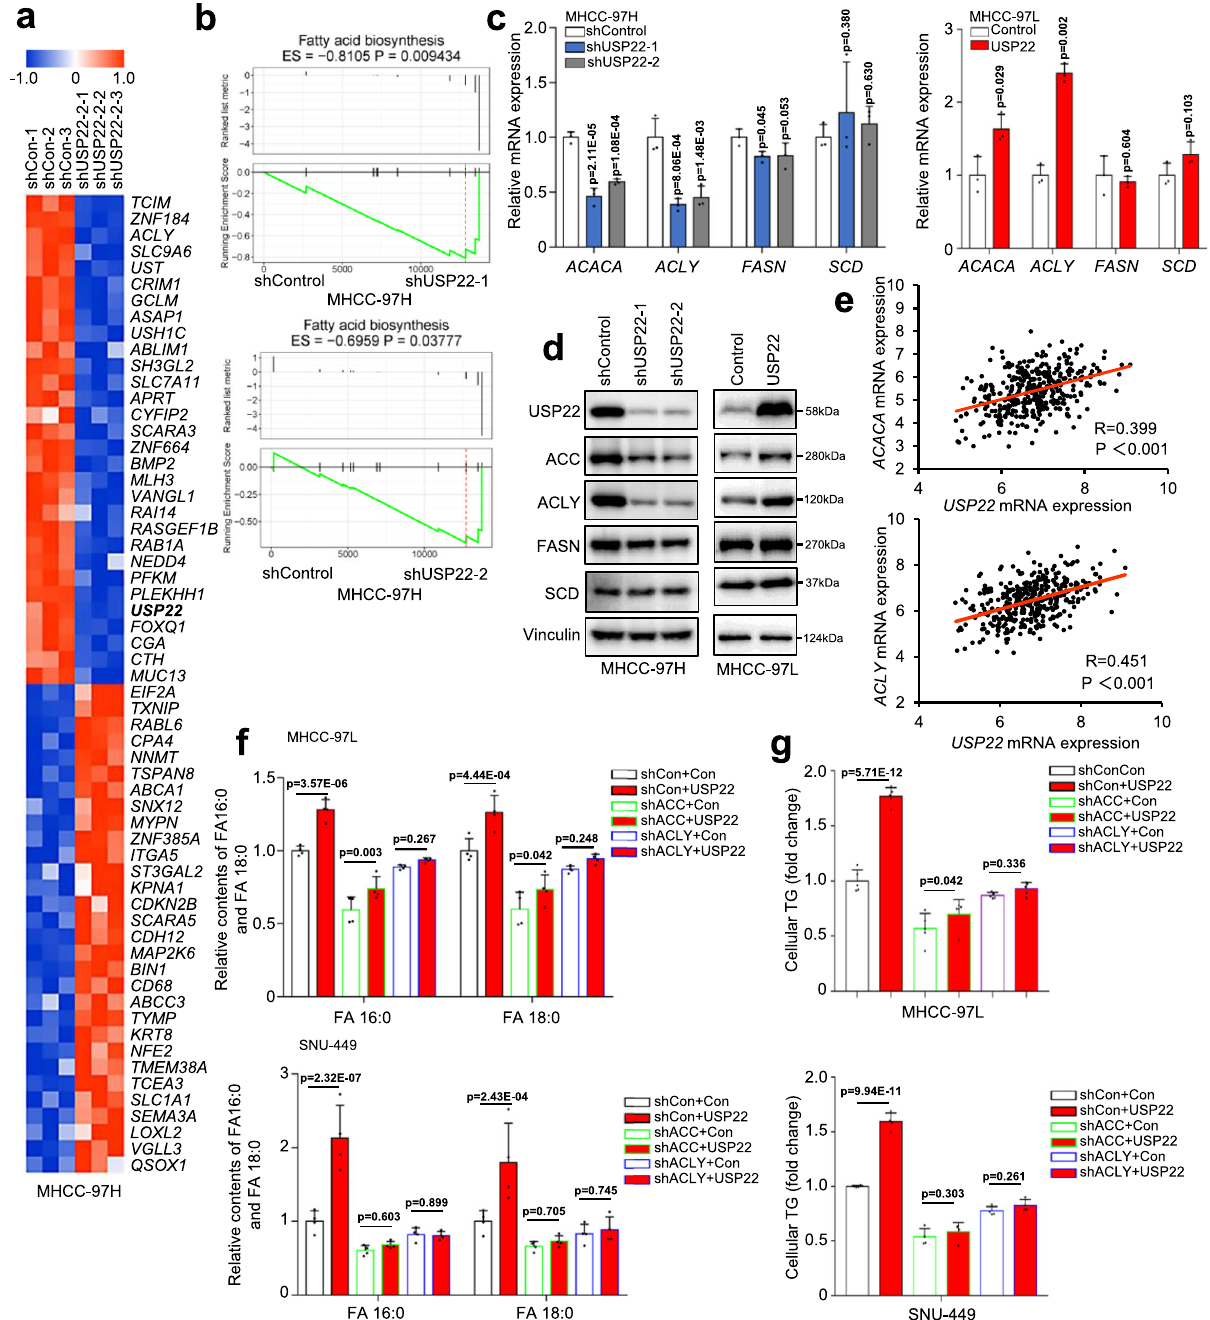
Fig. 3 USP22 upregulates ACC and ACLY expression. a Heatmap depicting the top 30 downregulated and upregulated genes in MHCC-97H cells transduced with USP22 shRNA ( Q < 0.05). Red and blue represent the Log2 fold change of an increase or decrease in mRNA expression compared to the control group, respectively. b Gene set enrichment analysis (GSEA) of fatty acid biosynthesis gene sets in the expression pro fi les of MHCC-97H cells transduced with two independent USP22 shRNAs. c , d qRT-PCR ( c ) and western blot ( d ) analysis of ACACA , ACLY , FASN and SCD , in MHCC-97H- shUSP22-1/2 cells and MHCC-97L-USP22 cells. The data shown represent the means (±SD) of biological triplicates ( n = 3). One-way ANOVA test. e Correlation analysis between USP22 and ACACA , ACLY based on the TCGA LIHC database. R represents the Pearson correlation coef fi cient. f Relative contents of FA 16:0 and FA 18:0 were analyzed in MHCC-97L and SNU449 cells transduced with USP22 alone or in combination with ACC or ACLY shRNA. Cells were analyzed by LC-MS after 24 h adherence. One-way ANOVA test. The data shown represent the means (±SD) of biological replicates. The experiments were repeated four times ( n = 4). g Relative content of TG was analyzed in the above cell lines from f . Cells were analyzed after 24 h adherence. The data shown represent the means (±SD) of biological triplicates. One-way ANOVA test. The data shown represent the means (±SD) of biological replicates. The experiments were repeated fi ve times ( n = 5). Source data are provided in the Source Data fi le.